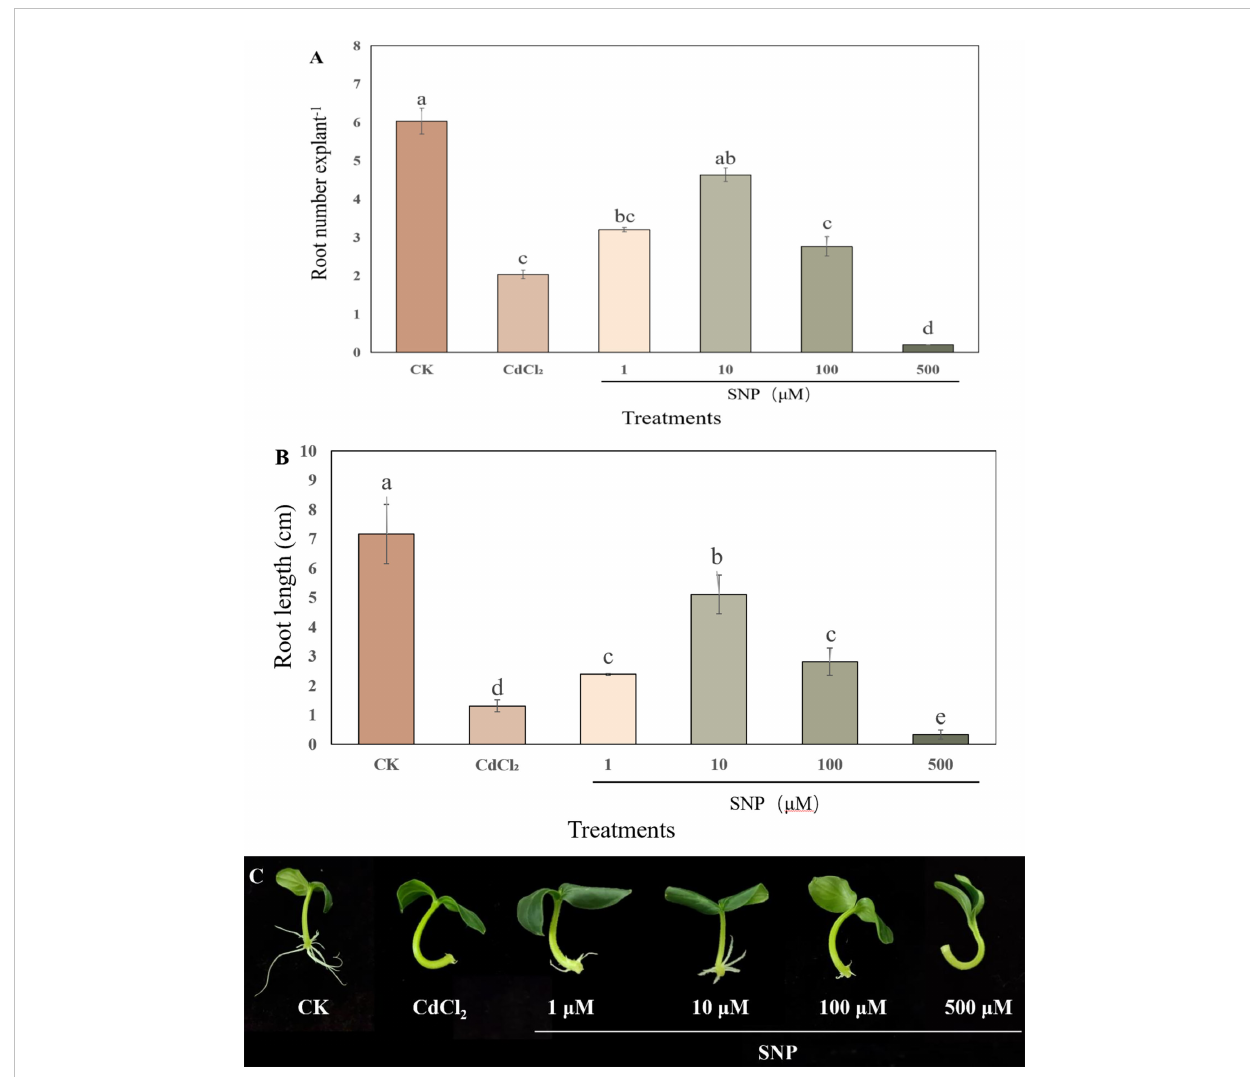
FIGURE 1 Effect of NO on adventitious root formation under Cd stress. The primary roots were removed from 5-day-old seedlings. Explants were then incubated for 5 days with distilled water (CK) or 1 m M CdCl 2 , 1 m M CdCl 2 +1 m M SNP, 1 m M CdCl 2 + 10 m M SNP, 1 m M CdCl 2 + 100 m M SNP, 1 m M CdCl 2 + 500 m M SNP. Ten explants were used per replicate. The numbers (A) and root length (B) of adventitious roots were expressed as mean ± SE (n = 3). Photographs (C) were taken after fi ve days of the treatments indicated. Bars with different letters are signi fi cantly different at P < 0.05 according to Duncan ’ s multiple range